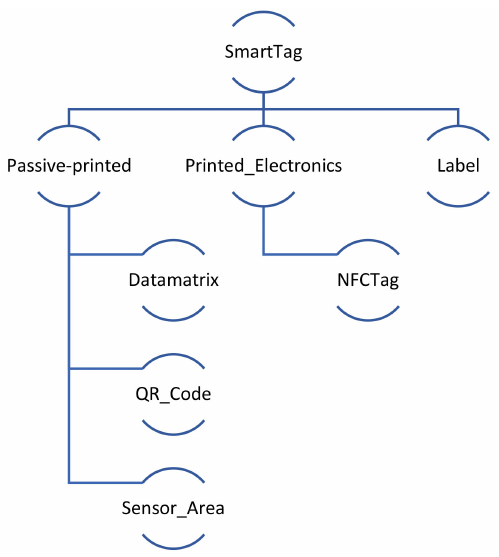
Figure 21. Top-level hierarchy for the SmartTag.